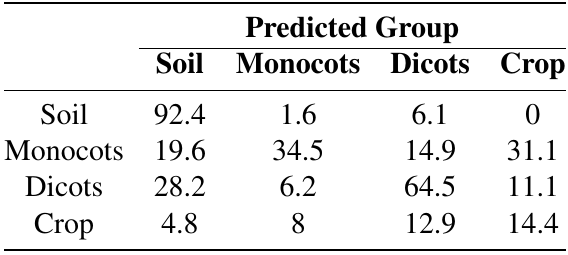
Table 2. Percentages of the original classes correctly classified by the Canonical Discrimination Analysis (CDA) in four predefined groups based on LIDAR